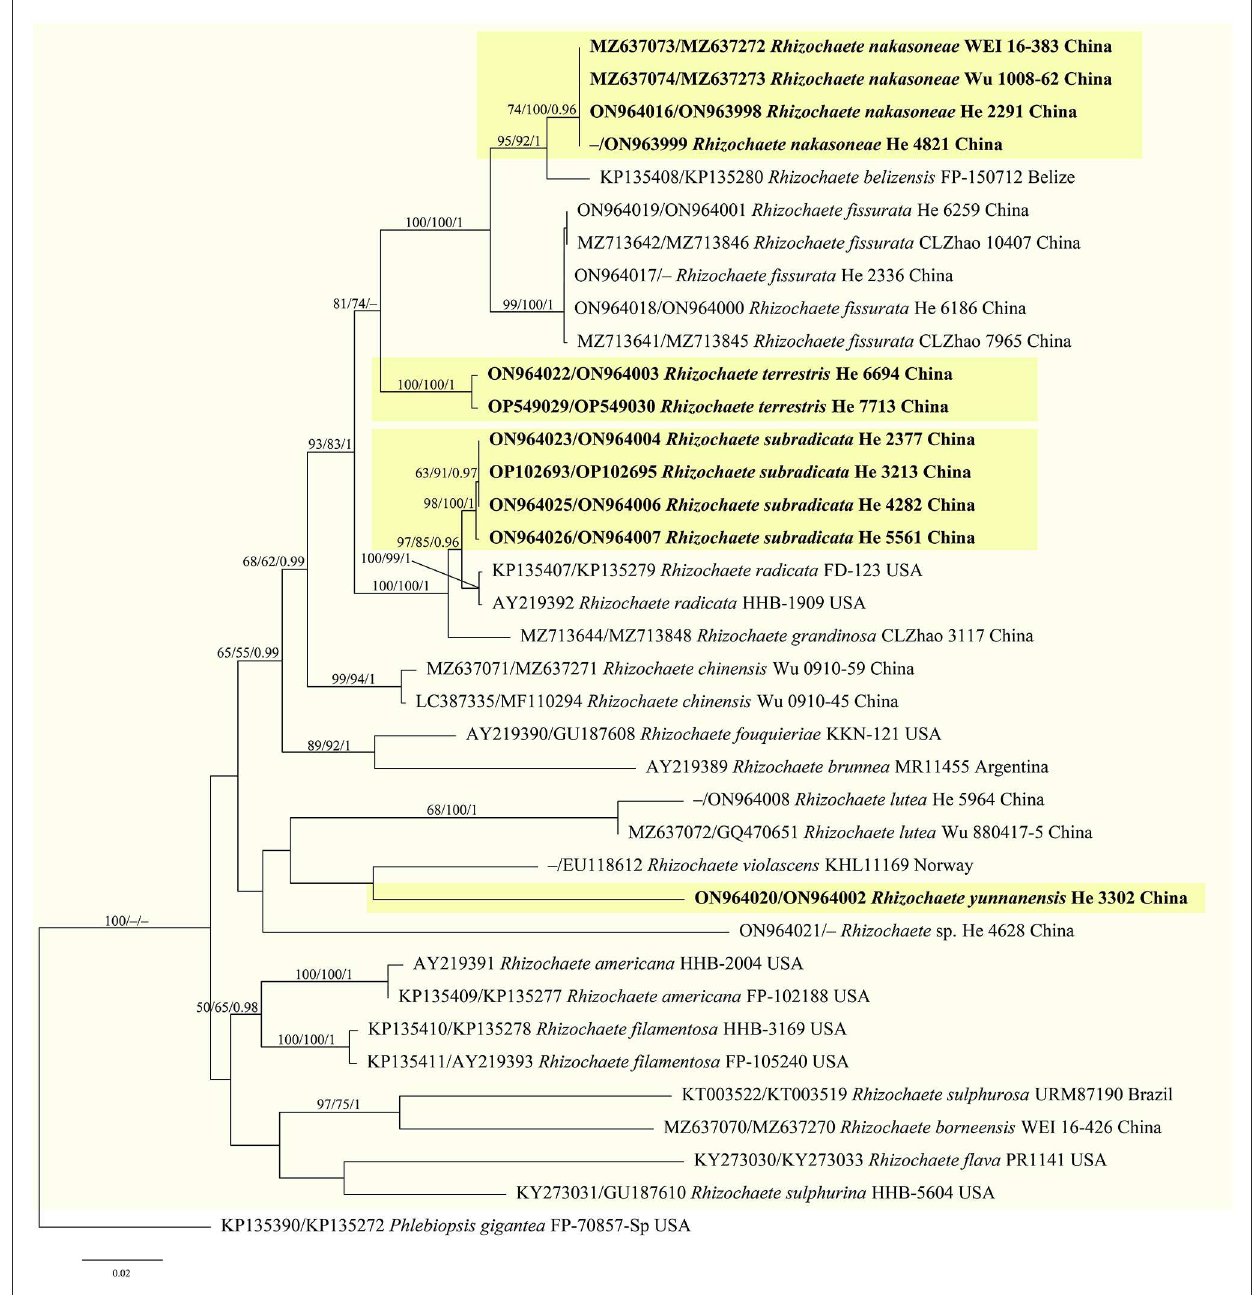
FIGURE3 Phylogenetic tree obtained from ML analysis of the ITS-nrLSU sequences of Rhizochaete . Branches are labeled with parsimony bootstrap values ( ≥ 50%, first), likelihood bootstrap values ( ≥ 50%, second), and Bayesian posterior probabilities ( ≥ 0.95, third). New species are set in bold and